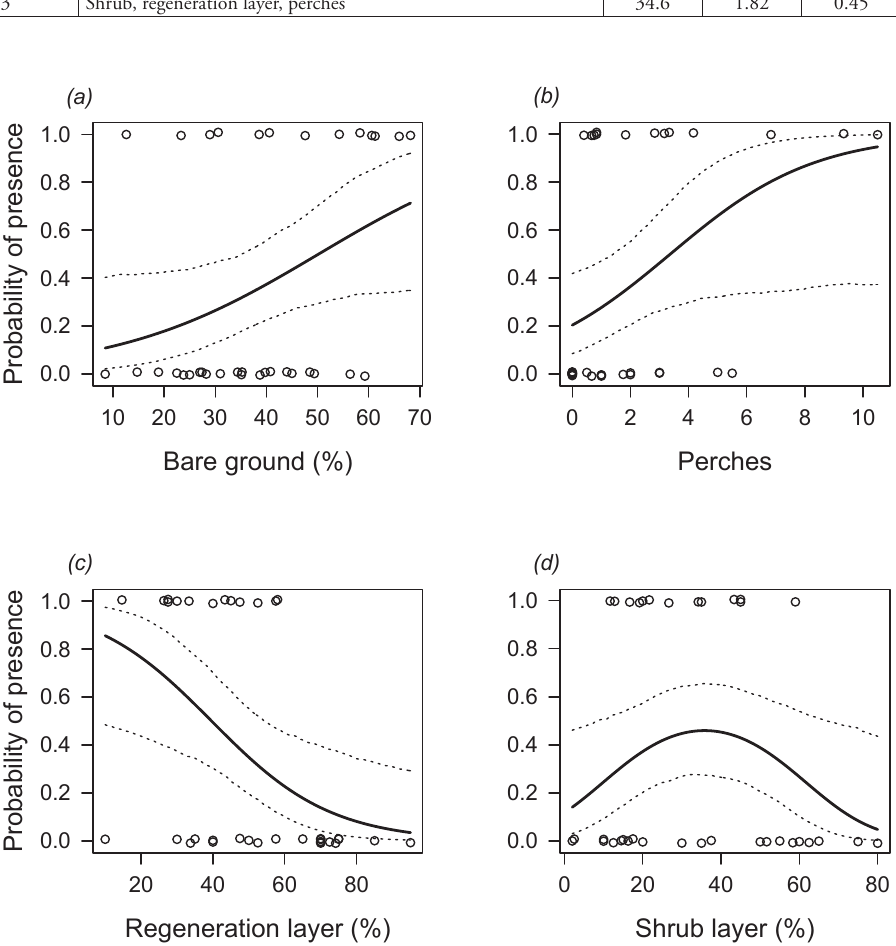
Figure 1. Probability of occurrence of Nightjar in relation to vegetation structure variables appearing in the most competitive models tested: a bare ground b perches c regeneration layer and d shrub layer. Vegetation structure variables are shown with regression lines and 95% confidence intervals (dotted lines), open circles = occupied (1) and abandoned (0) jittered in vertical